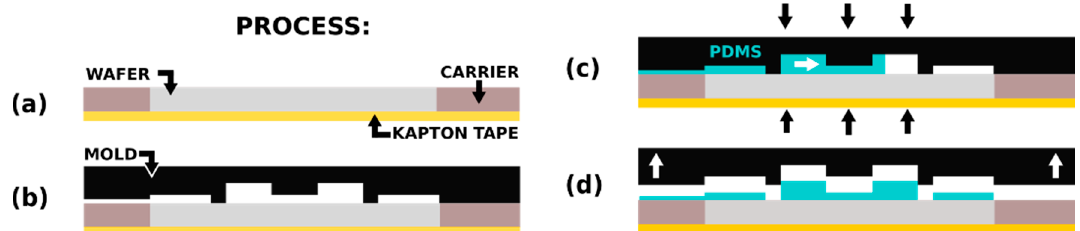
Figure 1. Process flow: ( a ) the wafer is loaded on a customized holder and inserted in an MMS- LM molding system, ( b ) the mold, protected by a 50 µm EFTE foil, is brought in contact with the wafer, ( c ) the uncured PDMS is loaded inside the molding machine and is injected into the mold cavities, and ( d ) the molding press opens and the wafer is